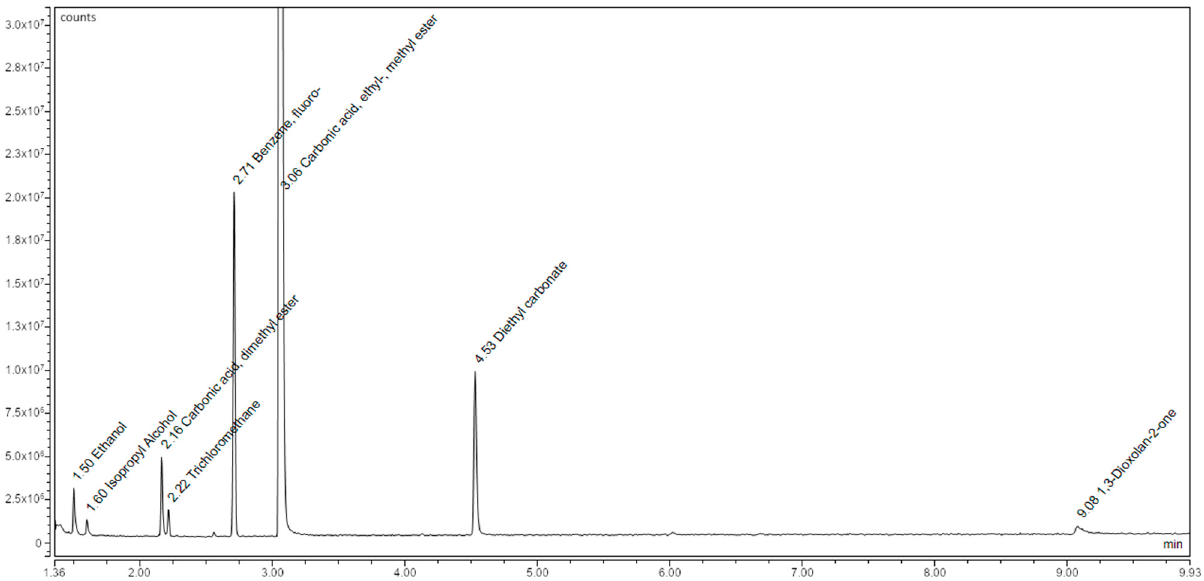
Figure 9. Chromatogram of headspace injection for estimation of carbonate ratio and identification of major organic solvents.